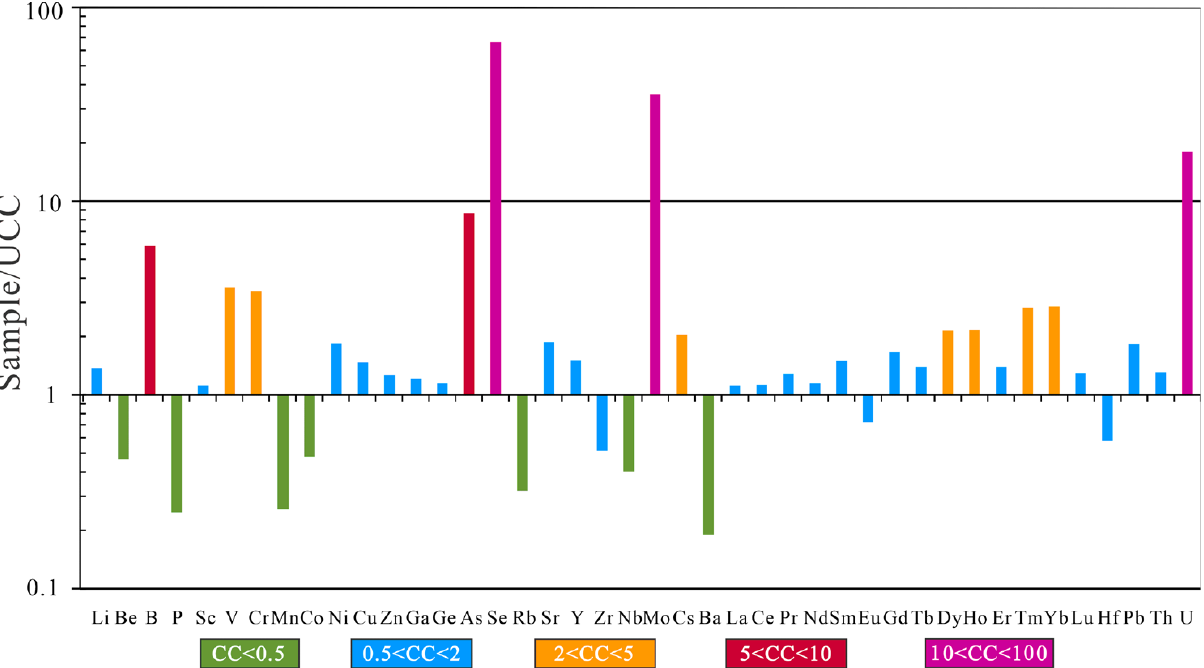
Figure 8. Concentration coefficient (CC) of trace elements in the studied samples, normalized to the respective average of upper continental crust composition (UCC; [22]).